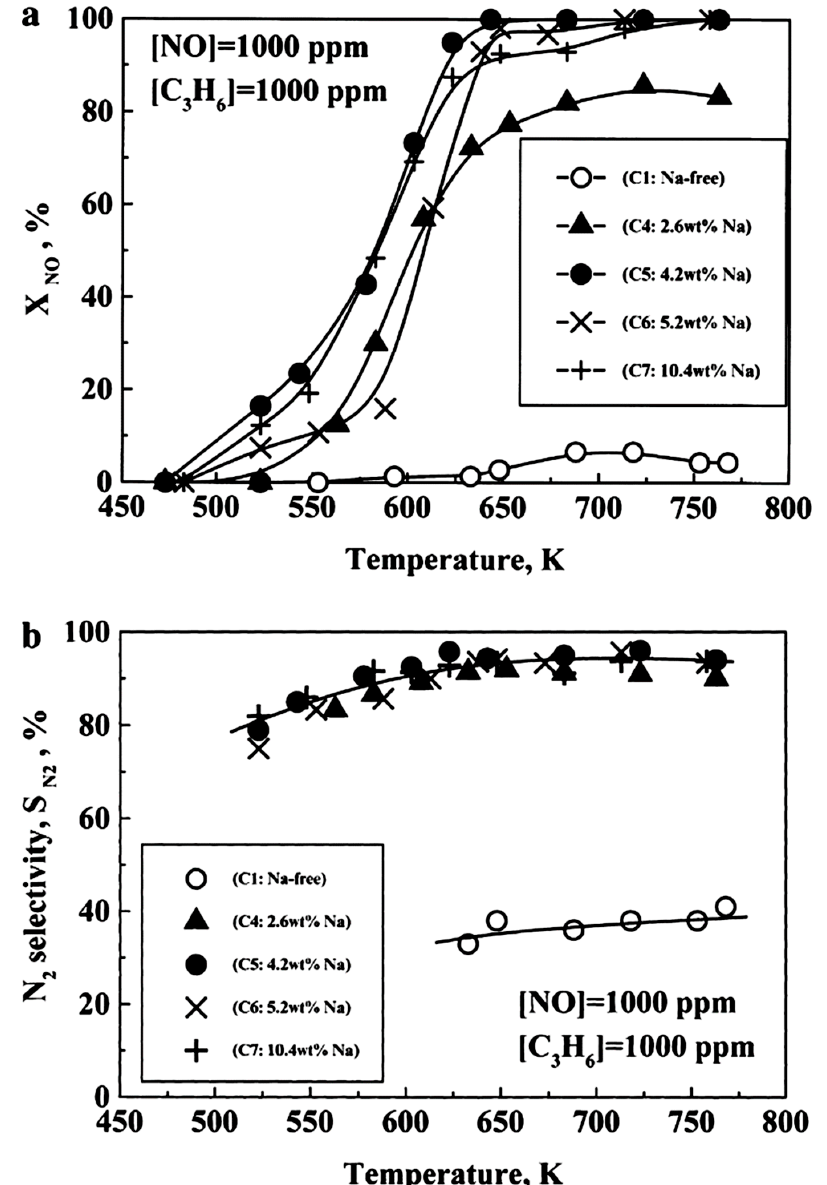
Figure 13. The conversion of NO ( a ) and the corresponding selectivity towards N 2 ( b ) for Na-promoted 0.5wt%Pt/ γ -Al 2 O 3 catalysts, as a function of temperature at constant reactor inlet conditions: [NO] = 1000 ppm, [C 3 H 6 ] = 1000 ppm; total flow rate F t = 80 cm 3 STP/min; catalyst weight 8( ± 0.2) mg. (Reprinted with permission from Ref. [15]; Copyright 1999, Elsevier).